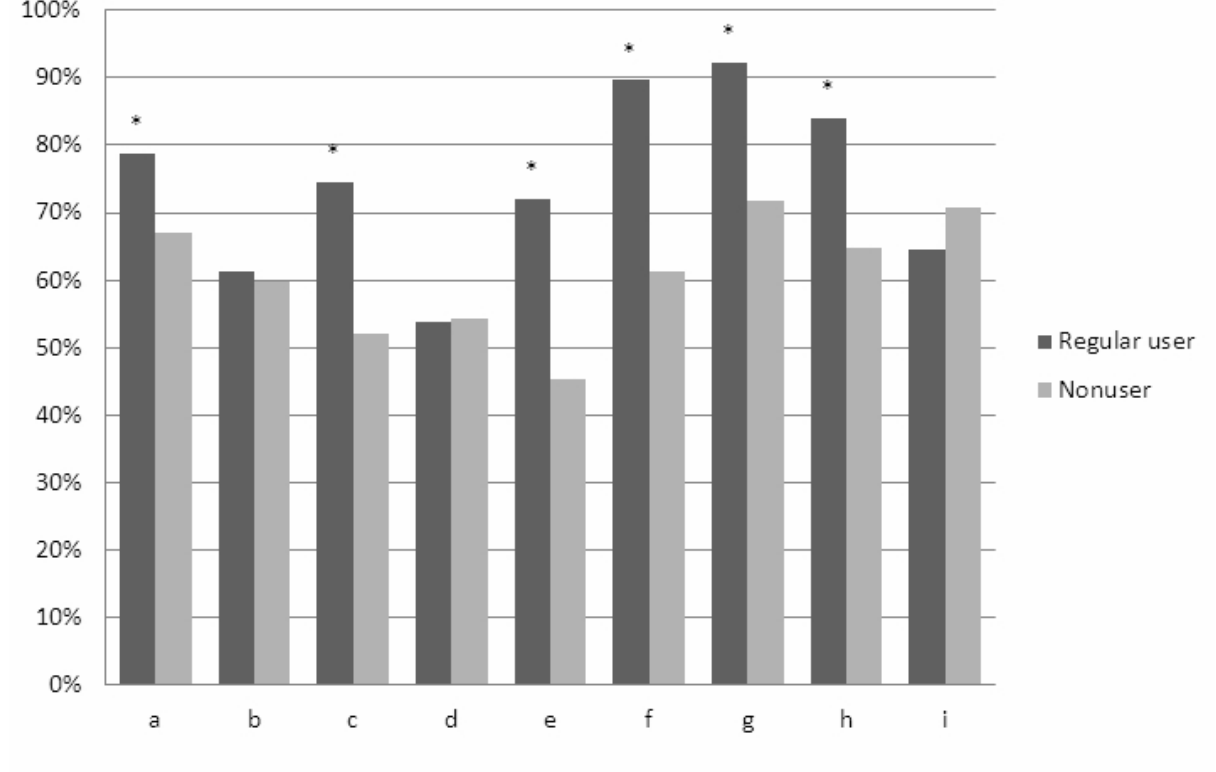
Figure 2. Differences between regular users (n=413) and nonusers (n=758) regarding the perceived usefulness (very useful or useful) of the content items of the patient Web portal. (a) overview of upcoming consultations, (b) summary of all health care physicians involved in treatment, (c) e-messaging, (d) general information about diabetes, (e) using the portal to upload the glucose levels measured at home, (f) rereading medical record after consultation, (g) access to laboratory values and treatment goals, (h) a summary of all consultations (history and future), (i) overview of medication. *